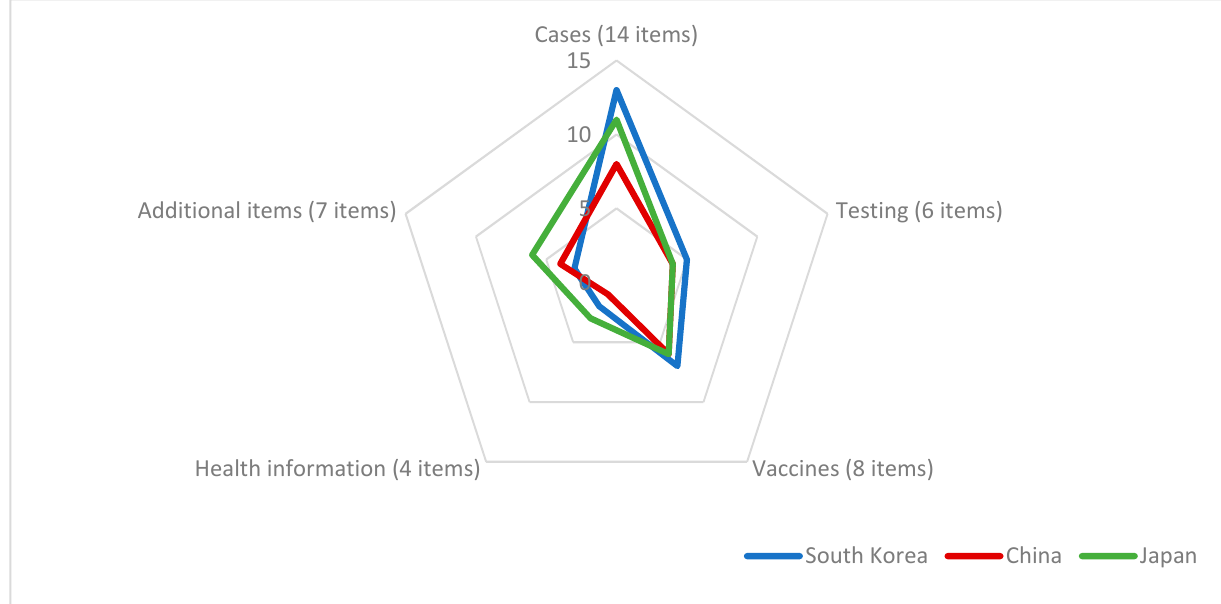
Figure 4. Healthcare information provided on the Japanese COVID-19 dashboards. ( A ): The proportion of hospital bed occupancy. (Note: Orange line: The proportion of the hospital bed occupancy for COVID-19, defined as the number of hospital beds used by COVID-19 cases divided by total hospital beds for COVID-19; Blue line: the proportion of the hospital bed occupancy for severe COVID-19, defined as the number of beds used by severe COVID-19 cases divided by total hospital beds for severe COVID-19) Source: Information on COVID-19 Infections. Japan Ministry of Health Labor and Welfare. https://covid19.mhlw.go.jp/extensions/public/en/index2.html (accessed on 30 October 2021) [44]; ( B ): Operational status of ventilators. Source: COVID-19 Information and Resources. Cabinet Secretariat, Government of Japan. https://corona.go.jp/dashboard/ (accessed on 14 October 2021) [45].